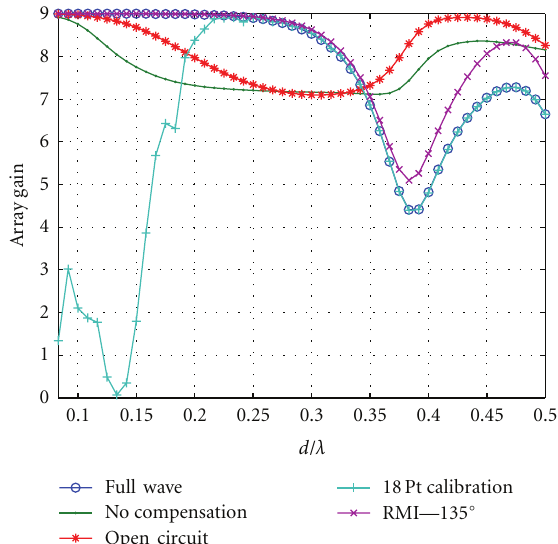
Figure 10: Array gain as a function of the electrical separation ( d/λ ) between the elements of the nine-dipole planar array for a signal arriving from φ = 0 ◦ and θ = 45 ◦ using the various mutual coupling compensation methods. Maximum gain is achieved for d/λ < 0 . 25 using the full-wave and receiving mutual impedance methods (RMI). The performance of the two methods degrades as frequency increases. The RMI method is slightly superior to the full- wave method for the plotted frequencies. For d/λ > 0 . 35, the open- circuit method is superior to all the other